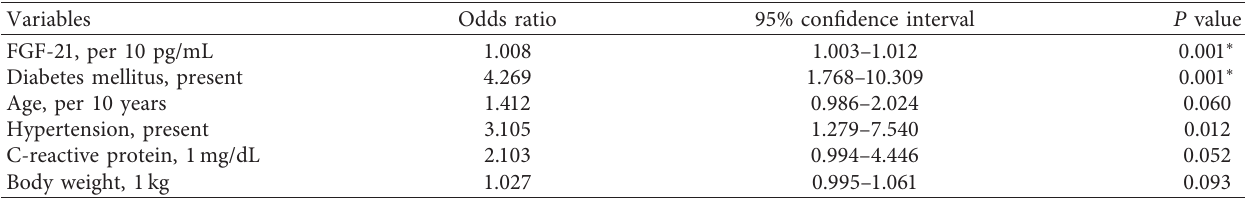
Figure 1: Comparison of fibroblast growth factor 21 levels between 130 hemodialysis patients with or without aortic Table 2: Multivariable logistic regression analysis of the factors correlated to aortic stiffness.